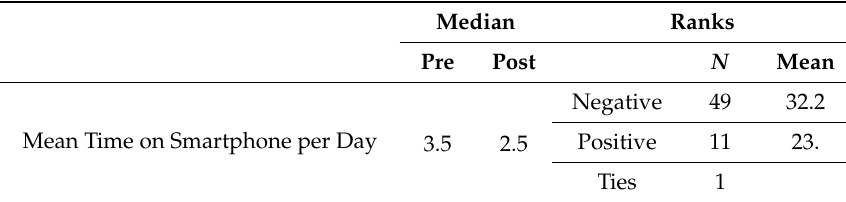
Table 3. Median and ranks for participants’ change in mean daily smartphone hours before and after abstinence. Median Ranks Pre Post N Mean Negative Mean Time on Smartphone per Day 3.5